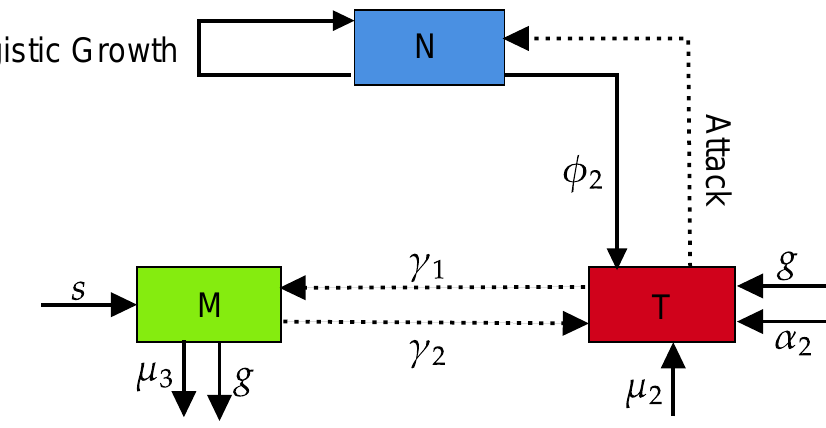
Figure 1. The cells’ population competition in the proposed